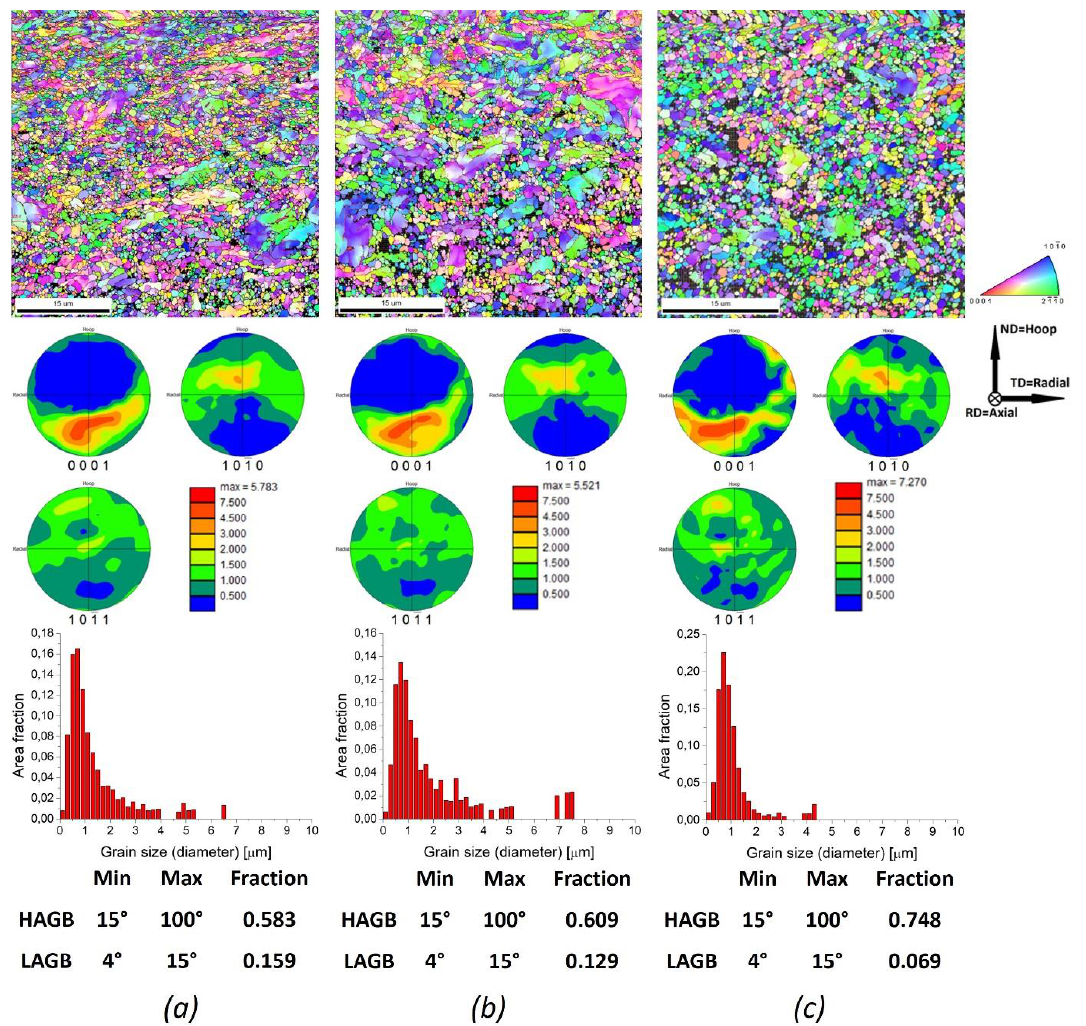
Figure 6. Grain orientation maps, local micro-textures, grain size distributions, and the HAGB and LAGB fractions of the sample after the second C-ECAP pass in the periphery ( a , c ) and in the center of the sample ( b